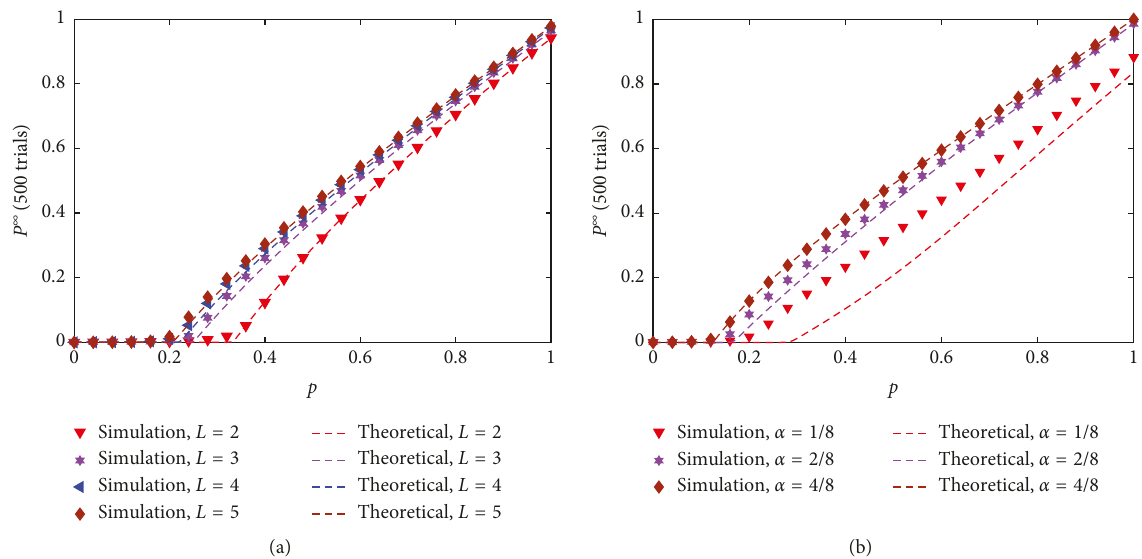
Figure 11: Validation of the correctness of the application of existing percolation theory for single-layer networks to multipartite networks. (a) Simulations on multipartite networks where each multipartite network has equal number of nodes for each partite set. (b) Simulations on bipartite networks where the number of nodes for each partite set of the focal network is controlled by parameter α